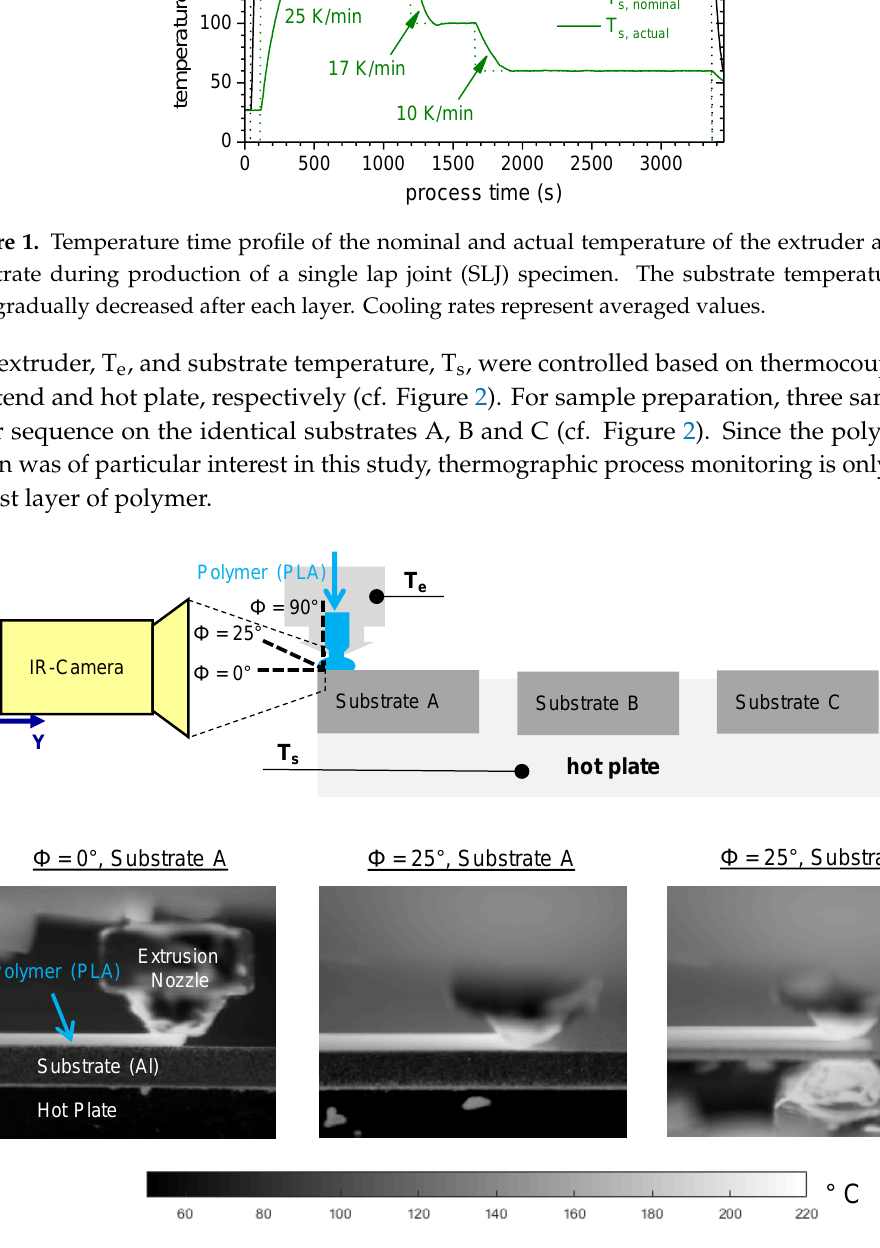
Figure 2. Schematic measurement setup of the three di ff erent thermographic measuring configurations with respect to the angle of vision ( Φ = 0 ◦ , 25 ◦ and 90 ◦ )—top (not to scale). Extract of emissivity corrected thermograms for di ff erent angles of vision and substrate positions during the material extrusion process (T e = 200 ◦ C, T s = 150 ◦ C) — bottom.